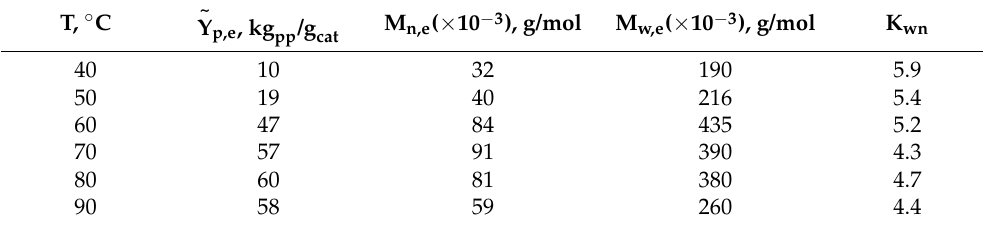
Figure 1. Comparison of MWD deconvolutions of PP samples obtained at polymerization tempera- tures: T = 40 ◦ C (1), T = 50 ◦ C (2), T = 90 ◦ C (3) (polymerization conditions in Table 2). Semi-solid curves show the distribution of polymer fractions formed on isolated active centers (Table 3). Table 2. Polymerization temperature effect on the experimental outputs and average proper- ties of PP synthesized on catalyst system TiCl 4 /DBP/MgCl 2 + TEA/CHMDMS (t p = 120 min, P = 30–32 kg/cm 2 , m H2 = 0.15 mol, m cat = 0.015 g of catalyst, f Ti = 0.025 mass., Al/Ti = 1500 mol, and Al/Si = 20 mol